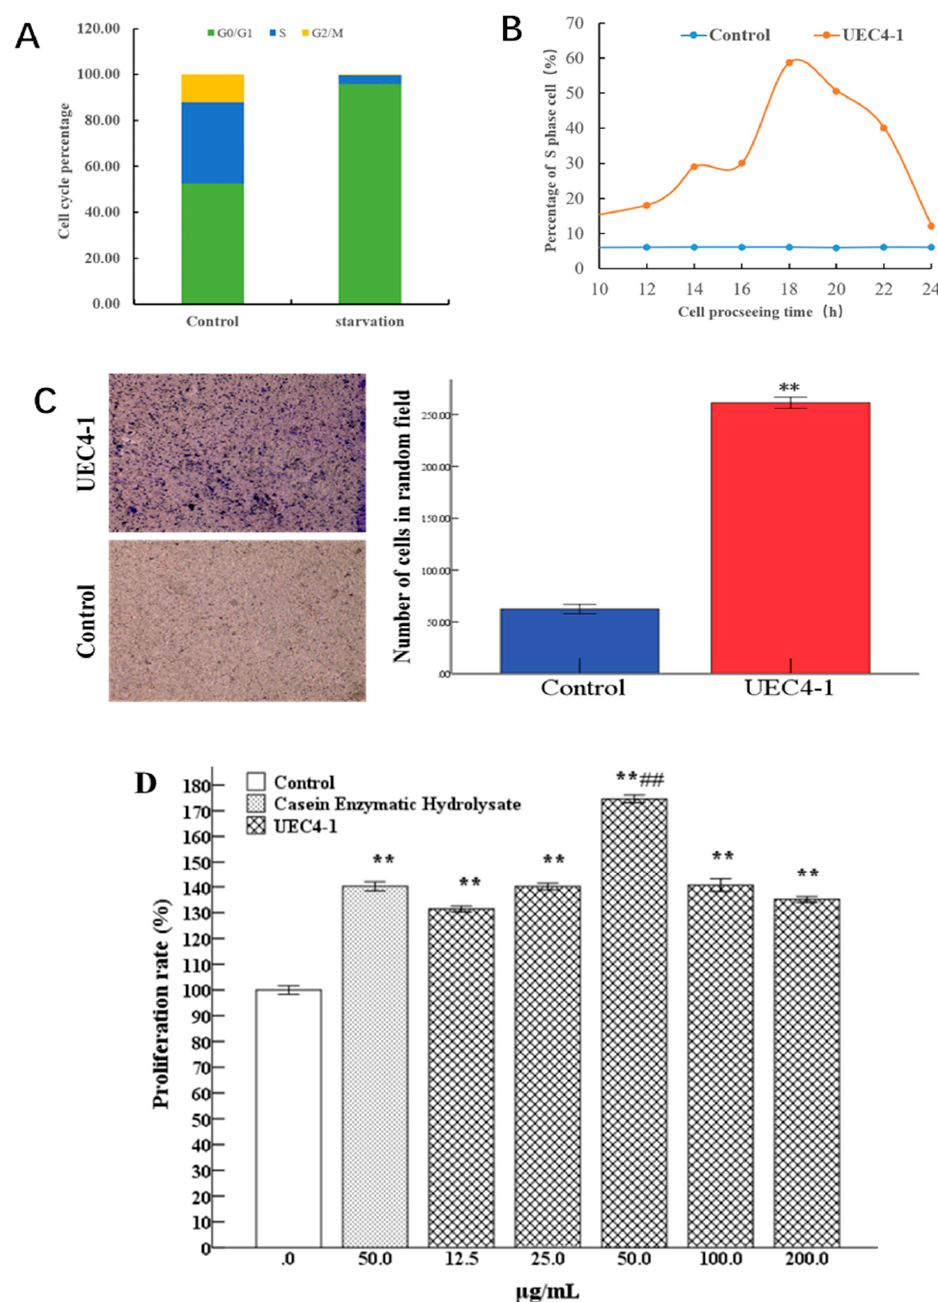
Figure 7. Evaluation of the effects of UEC4–1 on lactation. ( A ) Cell synchronization results; ( B ) UEC4-1 promoted the G1-S phase process of MCF-10A cells; ( C ) UEC4-1 promoted MCF 10A cells. ** significantly different from the control group at p < 0.01; ( D ) Effects of UEC4-1 on proliferation of MCF-10A cells. ** significantly different from the control group at p < 0.01; ## significantly different from the casein enzymatic hydrolysate group at p < 0.01.